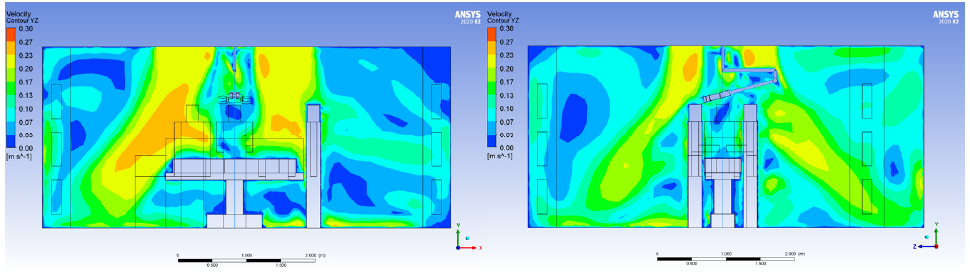
Figure 10. Air velocity profiles for variant 4 on the XY plane ( left ) and YZ ( right ).